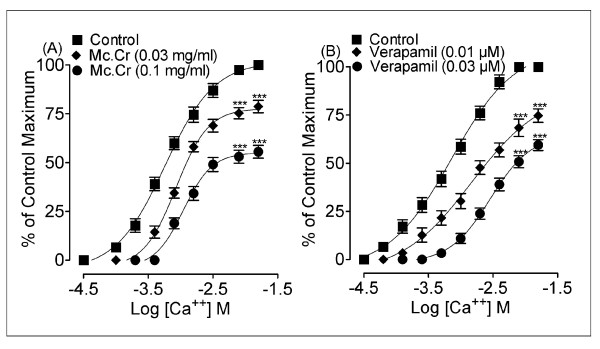
Concentration-response curves of Ca++ in the absence and presence of the increasing concentrations of Mc.Cr (A) and verapamil (B), constructed in Ca++-free and K+-rich (80 mM) Tyrode's solution in isolated rabbit jejunum.***P < 0.001; compared to the respective control.